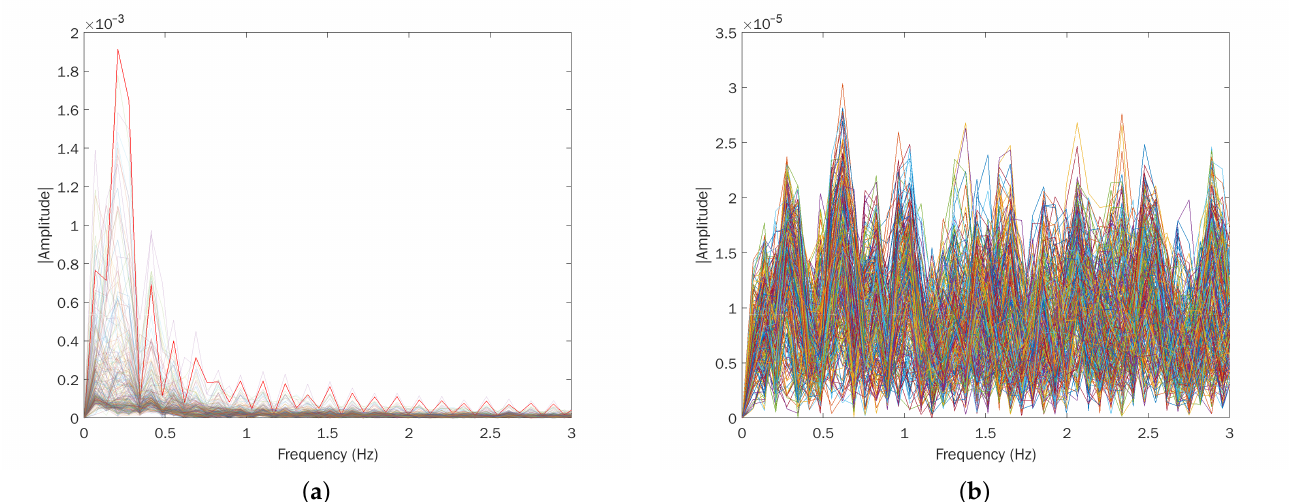
Figure 11. Simple spectrum comparison in LOS conditions between present and absent human target scenarios. ( a ) Signal spectrum with human target. The fundamental harmonic related to respiration is highlighted in red ( ≈ 13 breaths/min), while the others are at multiple frequencies with decreasing amplitudes. ( b ) Signal spectrum without human target.